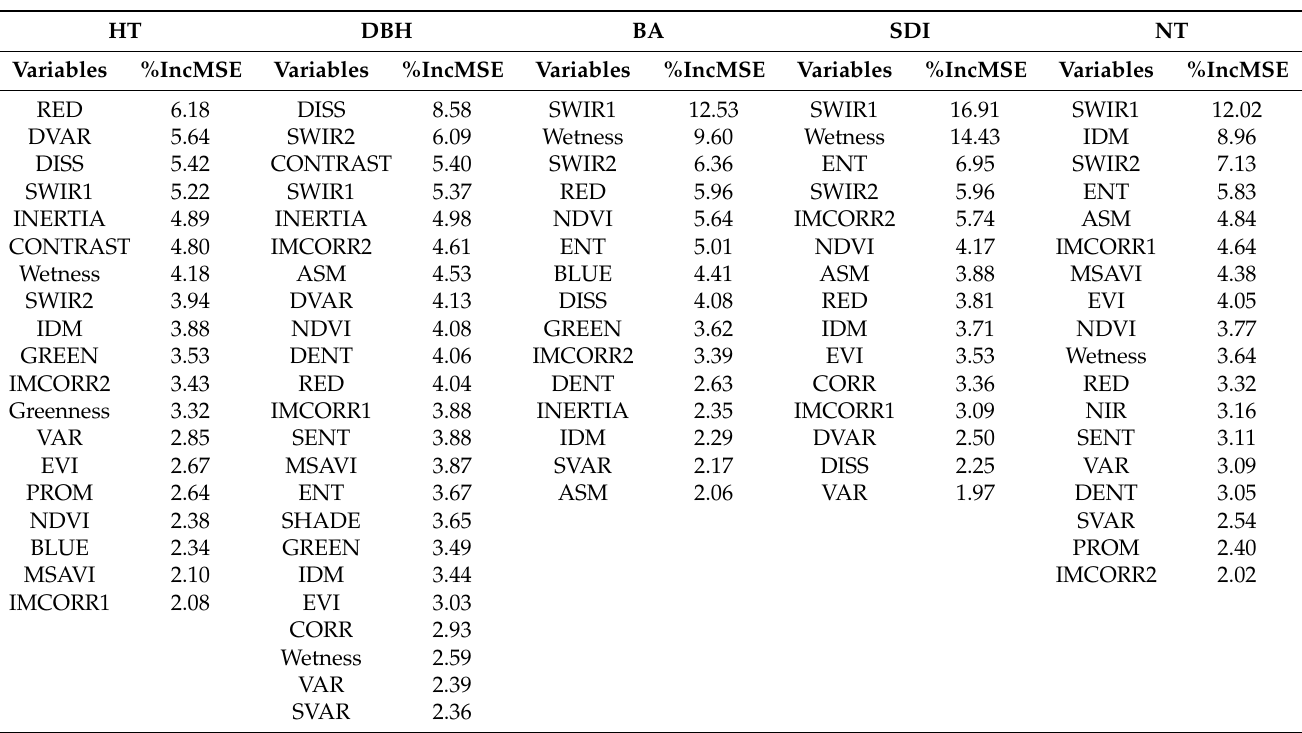
Table 7. Relative importance of predictors with %IncMSE ≥ 2 by random forests models using the training dataset for the 3rd cycle measurement.